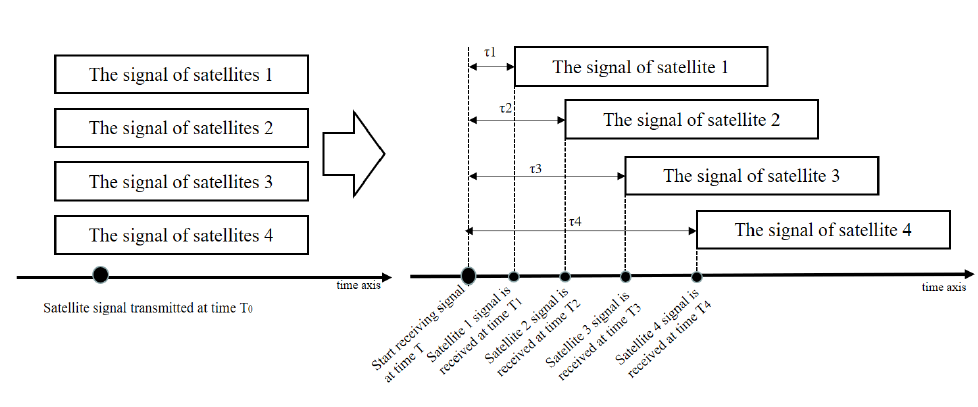
Figure 4. Example timing diagram of signal received by GPS receiver in four-star positioning.